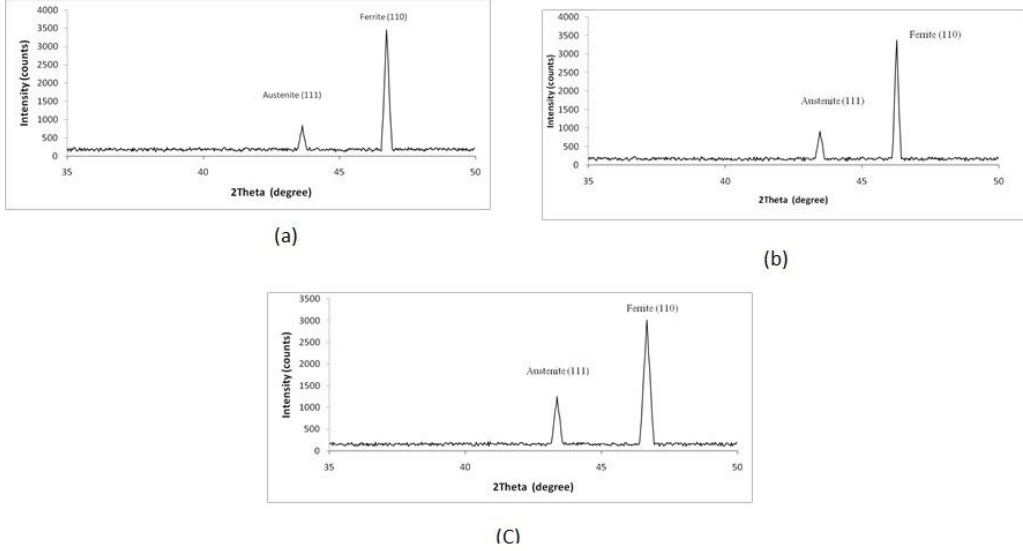
Figure 6. XRD graphs for ADI samples with 0.64 wt% Mn, austenitized at 950ºC and austempered at (a) 320, (b) 370, and (c) 420ºC.